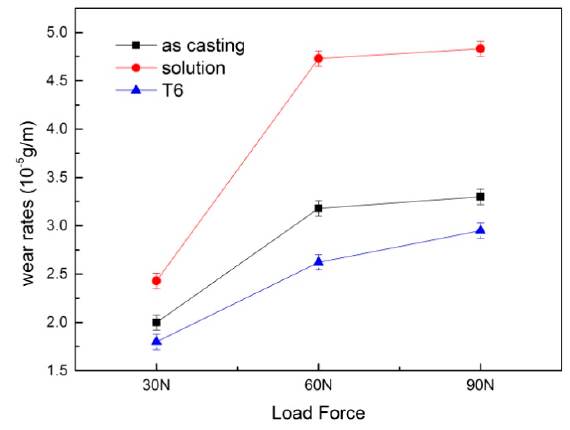
Figure 8. The wear rates of AZ91-1.0Pr as-cast and after heat treatment.